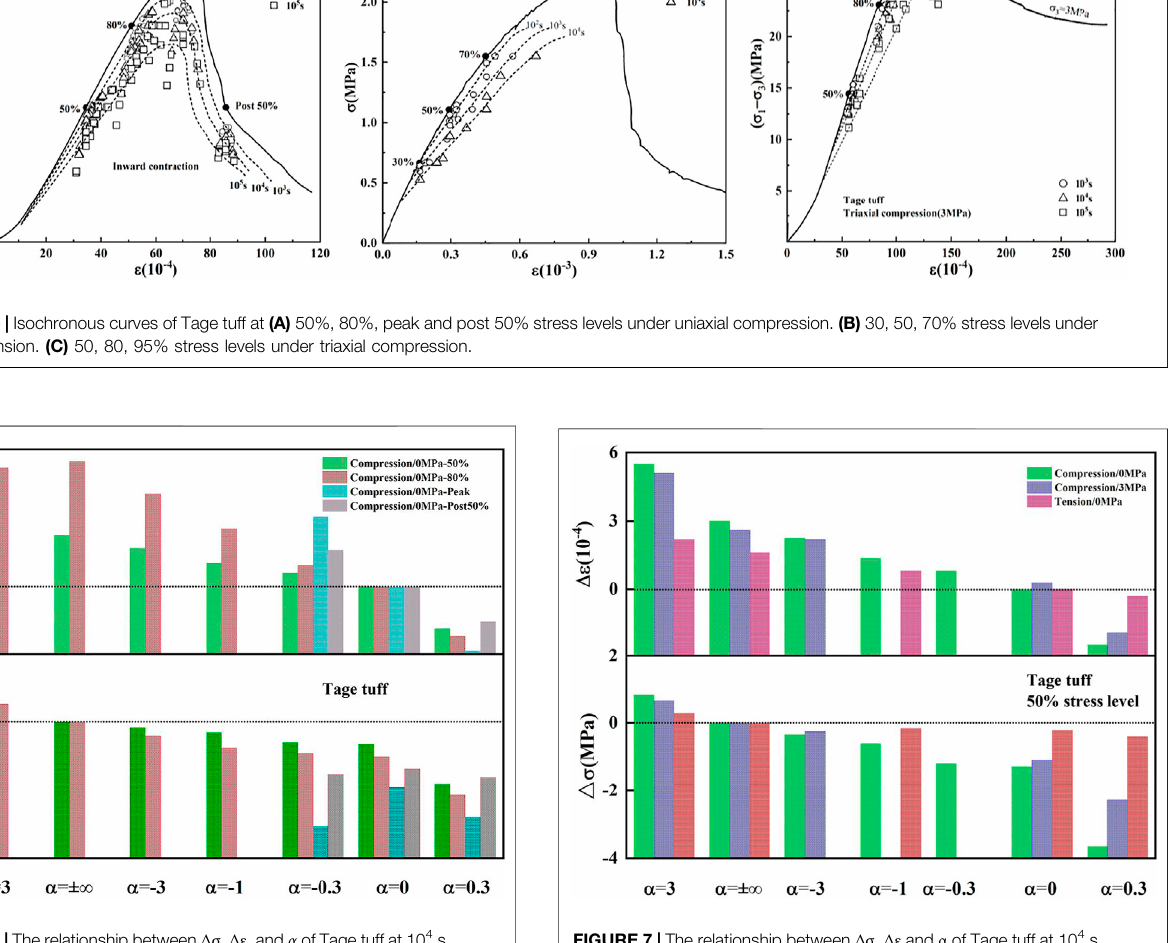
FIGURE 6 | The relationship between Δ σ , Δ ε , and α of Tage tuff at 10 4 s under uniaxial compression of different stress levels. The solid points are variations of strain, and the dotted points are variations of stress.